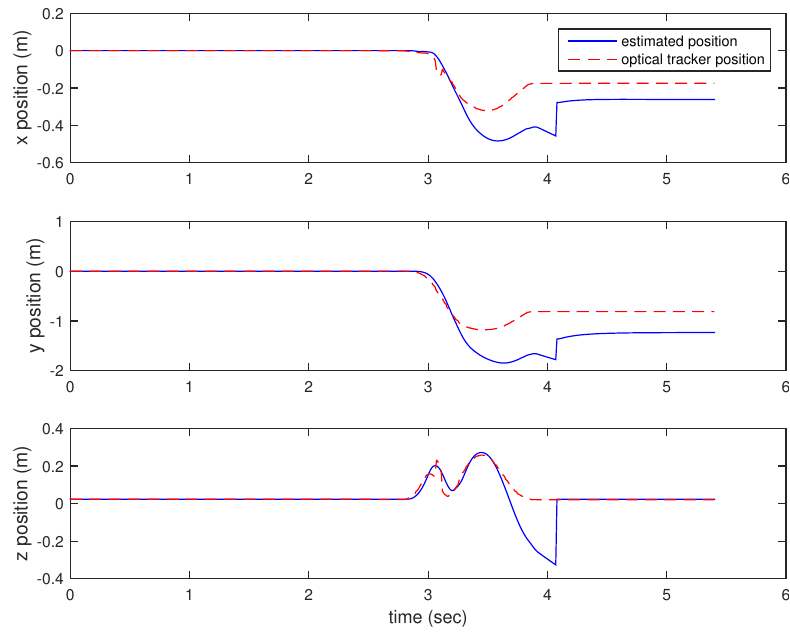
Figure 7. Ball kicking estimation: K.F. (zero velocity + height updating).